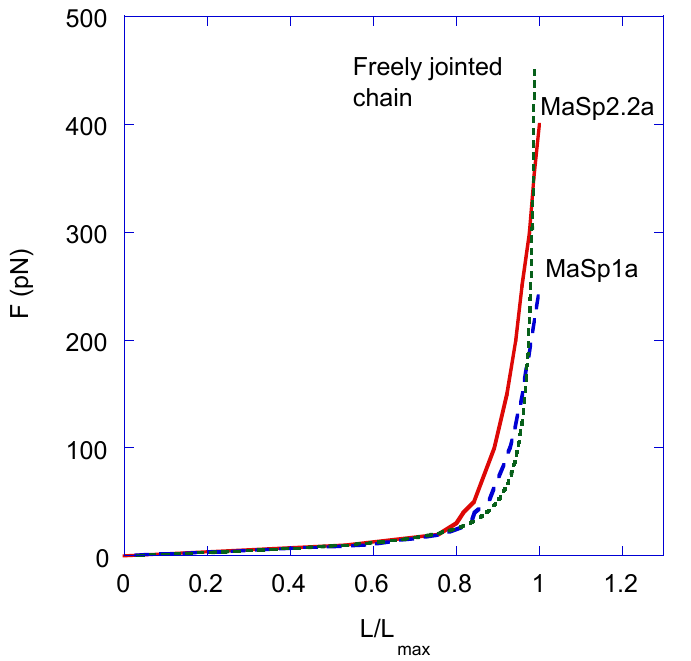
Figure 4. Force vs. L/L max curves plotted with the data of the MD simulations (see Supplementary Table S1). The theoretical curve is calculated from Equation (1), assuming a length of the links of a = 8.1 Å and a temperature of T = 298 K.